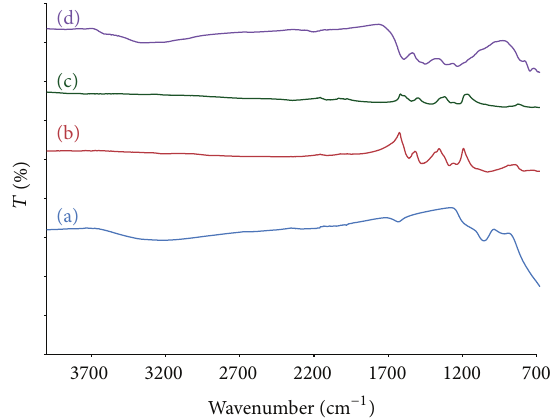
Figure 1: FTIR spectra of (a) TiO 2 , (b) Polyaniline, (c) TiO 2 /PANi, and (d) TiO 2 /AC,